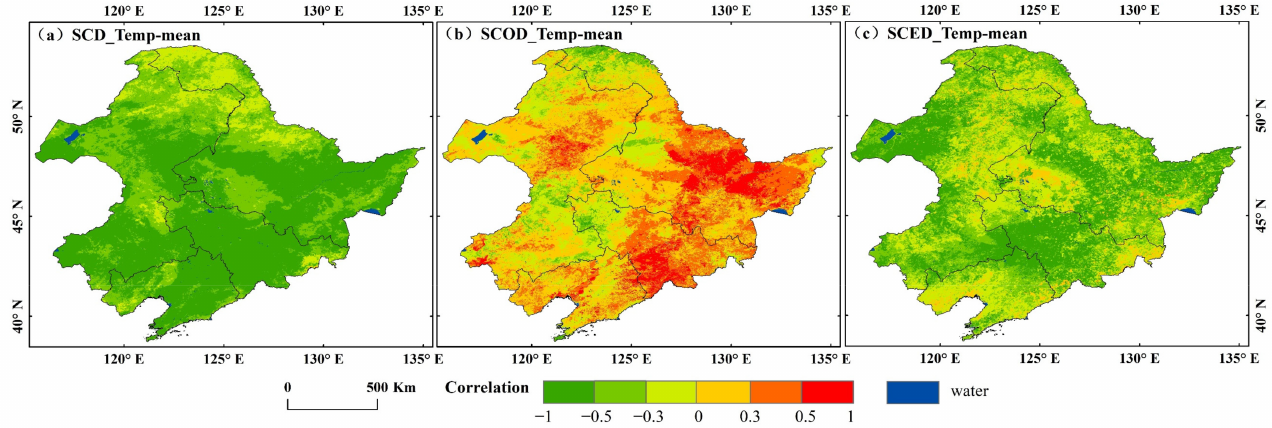
Figure 15. Spatial pattern of the correlations between the mean temperature and snow phenology. ( a ) SCD, ( b ) SCOD, ( c )